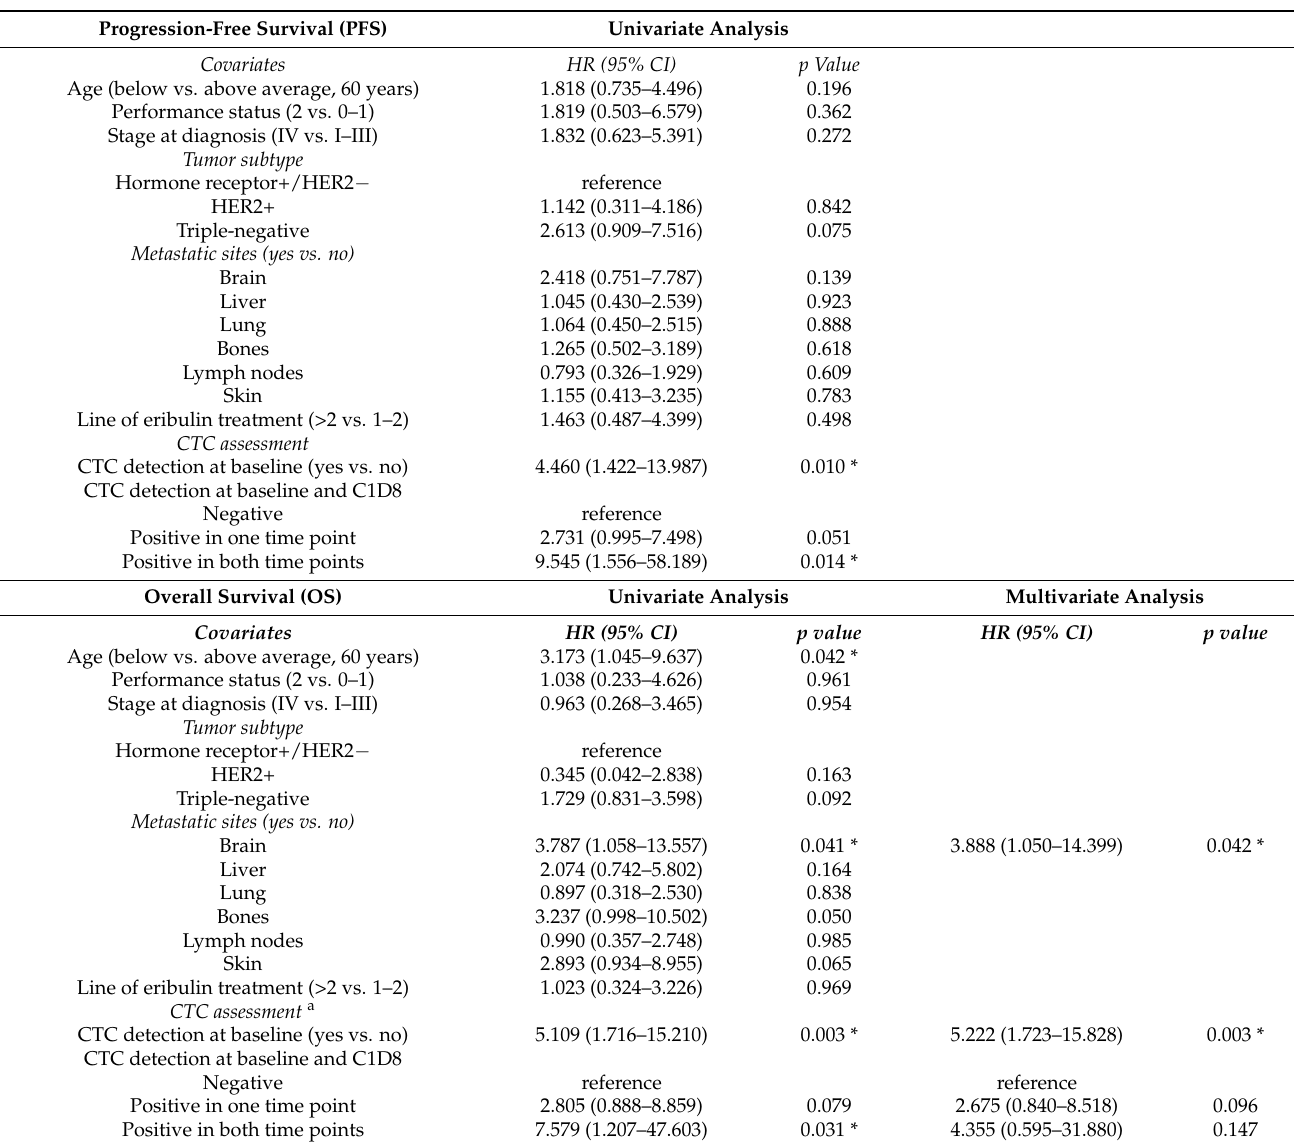
Table 4. Cox regression analysis for PFS and OS prediction in metastatic BC patients who were eligible for CTC monitoring ( n =